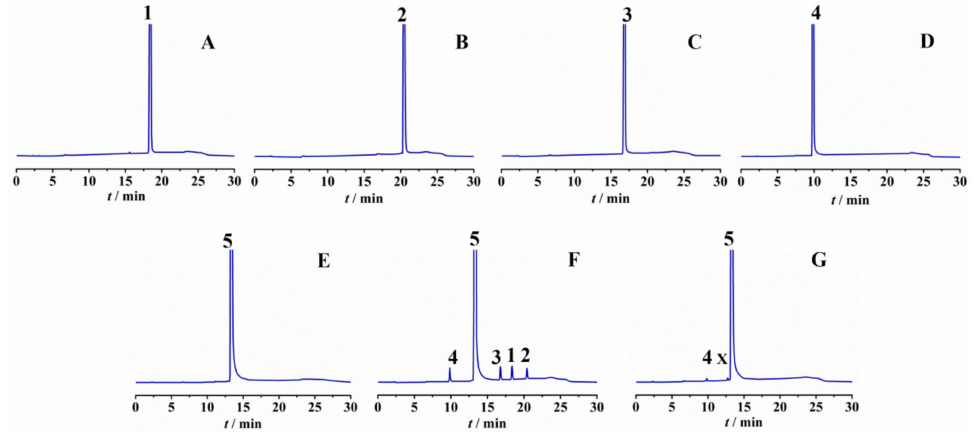
Figure 4. Detection of related substances in LM49-API by HPLC by method C ( A ) LM49-02 reference